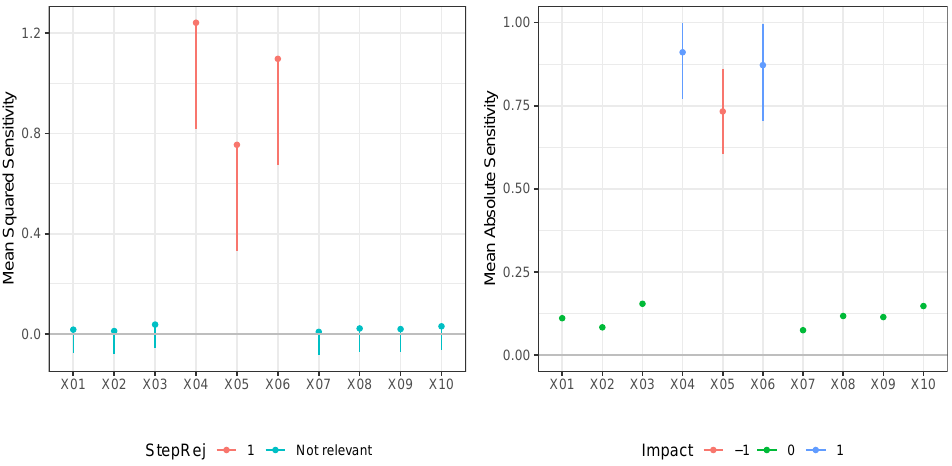
Figure 3. Model M2 (De Vleaux). Case n = 300. ( left ) Values of test statistic T n and critical values T n − ˆ c ( 1 − α , k ) . ( right ) Values of mean absolute sensitivity along with bootstrap confidence limits with B = 1999 bootstrap replicates and nominal level 1 − α = 0.90 for relevant variables to the